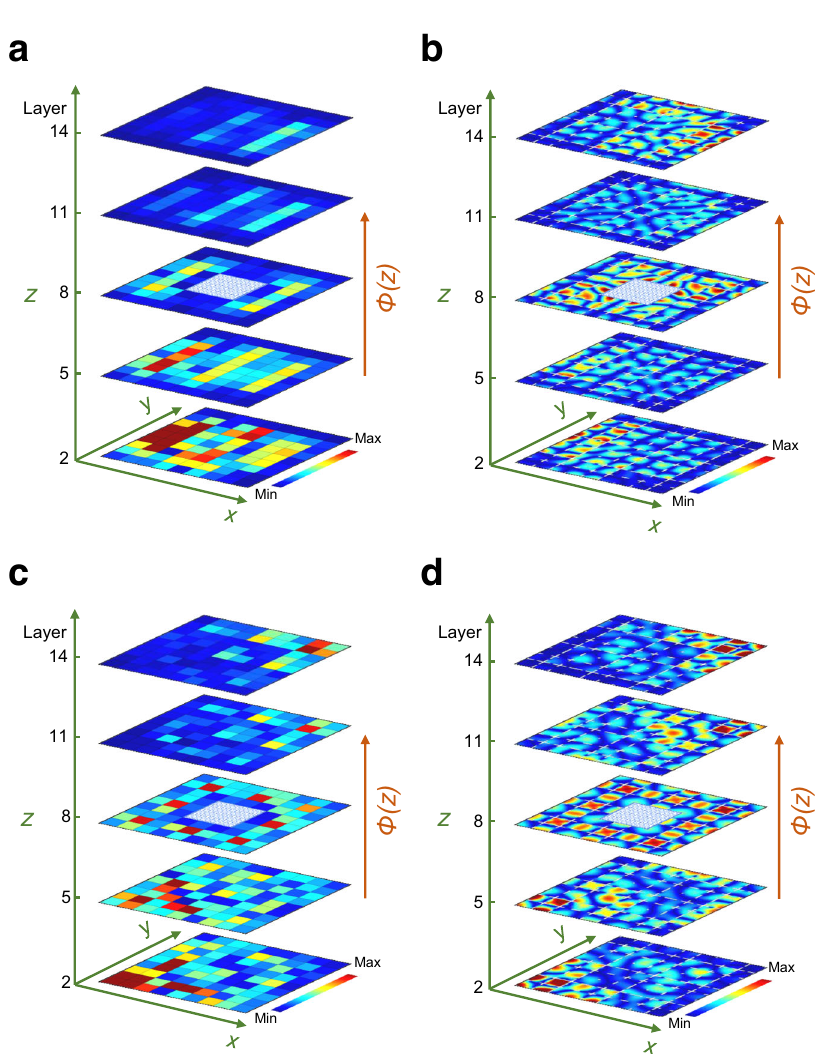
Fig. 4 Robust topological pumpings in the 3D hollow acoustic crystal. a , b Experimental a and numerical b observation of edge-bulk-edge pumping. The sound is injected at the bottom-left edge with the frequency at f ¼ 7498Hz. c , d Experimental c and numerical d observation of corner-bulk-corner pumping. The sound is injected at the bottom-left corner with the frequency at f ¼ 6175Hz. Note that the pumping parameter ϕ ð z Þ for each horizontal layer of these samples is evenly distributed from (cid:4) 0 : 2 π to 0 : 2 π along the z -direction and the hollow area is indicated by the blue grid plane where nine cavities are removed. The color scale corresponds to the pressure amplitude.